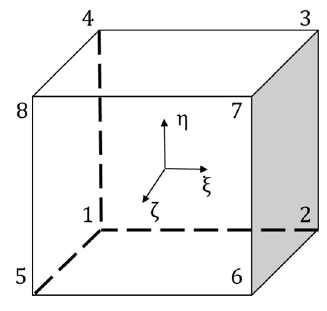
Figure 1. Isoparametric hexahedral element with node number.